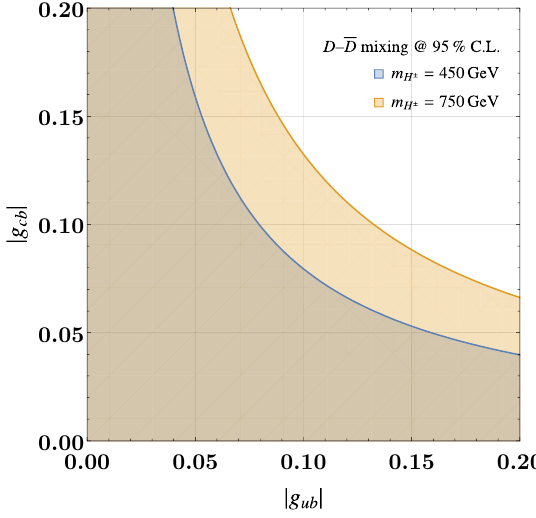
Figure 2 . Region in the g ub – g cb plane allowed by D -meson mixing at 95% CL. The constraint on the product of both couplings scales linearly with the charged Higgs mass to very good